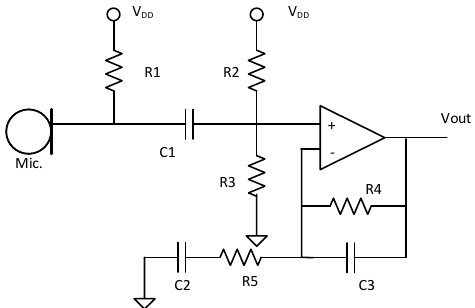
Figure 4. Amplifying circuit for the microphone.